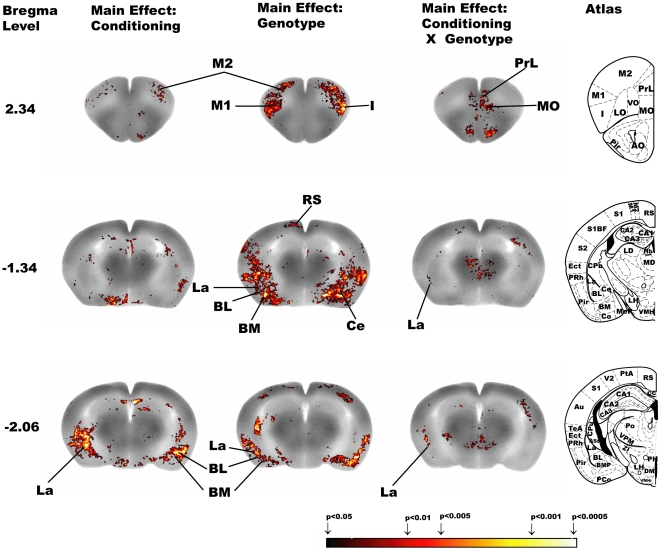
Factorial analysis examining the effect of genotype, conditioning or the interaction.Depicted are select coronal slices (anterior-posterior coordinates relative to bregma) of the template brain. Colored overlays show statistically significant effects of genotype or conditioning or their interaction, but do not reflect the direction of the effect. Abbreviations are from Franklin and Paxinos mouse atlas [67]: BL (basolateral amygdaloid nucleus), BM (basomedial amygdaloid nucleus), Ce (central amygdala), I (insular cortex), La (lateral amygdaloid nucleus), M1 (primary motor cortex), M2 (secondary motor cortex), MO (medial orbital cortex), PrL (prelimbic cortex), RS (retrosplenial cortex). Mouse brain atlas figures were reproduced from the mouse brain atlas [67] with modification and with permission from Elsevier.